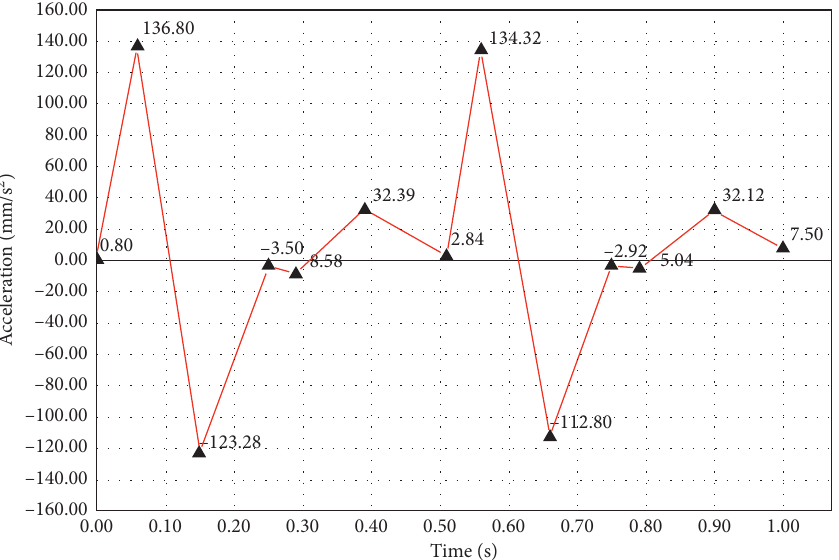
Figure 36: Measured acceleration at the top of the foundation pit cover near the